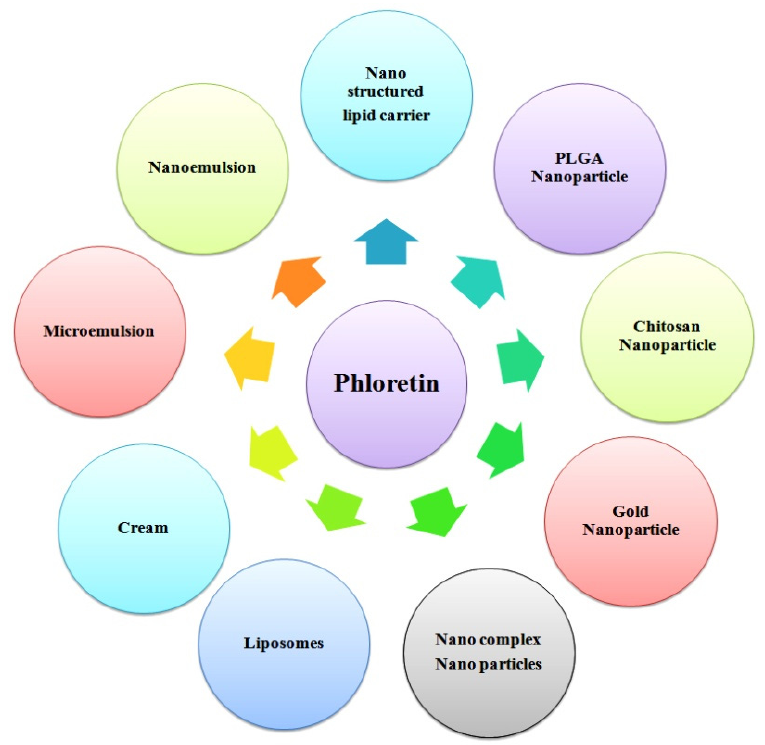
Figure 5. Drug delivery systems to improve absorption and bioavailability of phloretin.